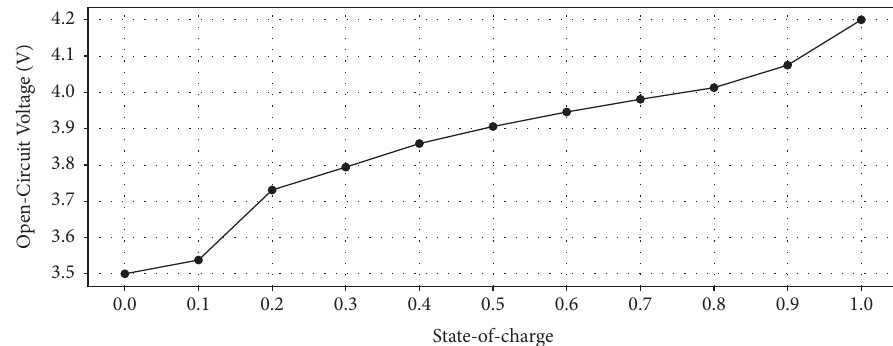
Figure 2: Cell open-circuit voltage values at diferent